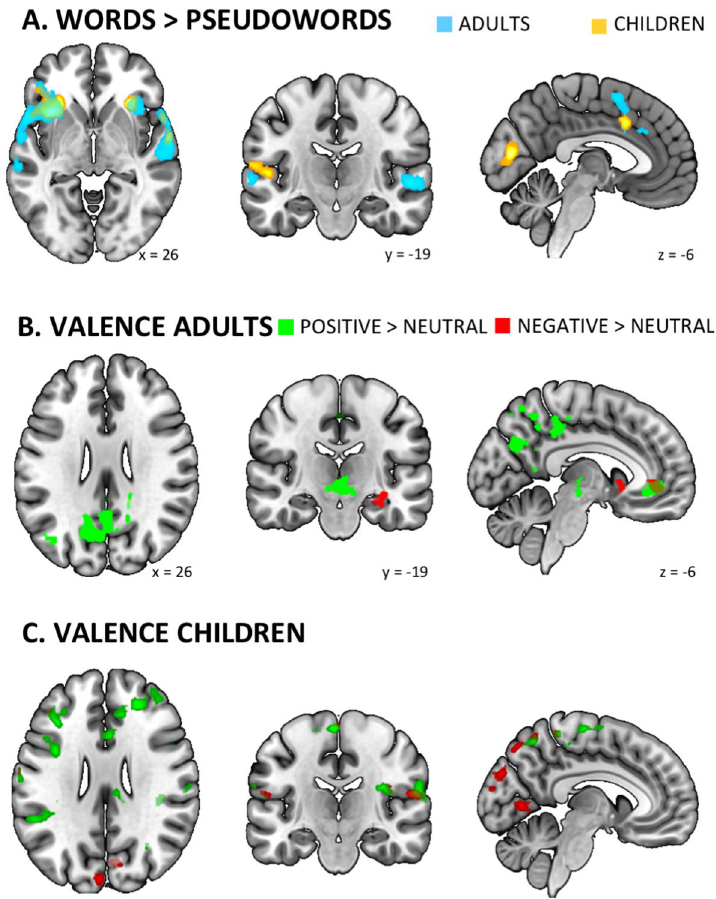
Figure 1. ( A ) Blood oxygen level dependent (BOLD) response showing greater activation for words compared to pseudowords in adults (blue) and children (yellow) and their overlap (green). ( B ) BOLD response in adults for the contrast positive compared to neutral words in green and for the contrast negative compared to neutral words in red. ( C ) BOLD response in children for the contrast positive words compared to neutral words in green and for the contrast negative compared to neutral words in